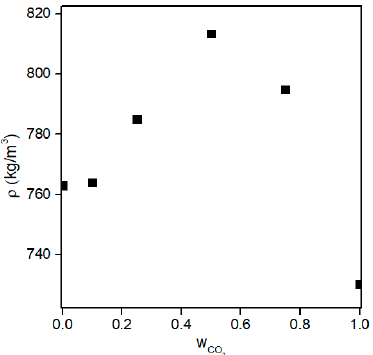
Figure 13. Density of acetone-CO 2 mixture with respect to CO 2 weight fraction at ~325 K and ~14 MPa. Data is taken from [82]. Copyright 2017 American Chemical Society.